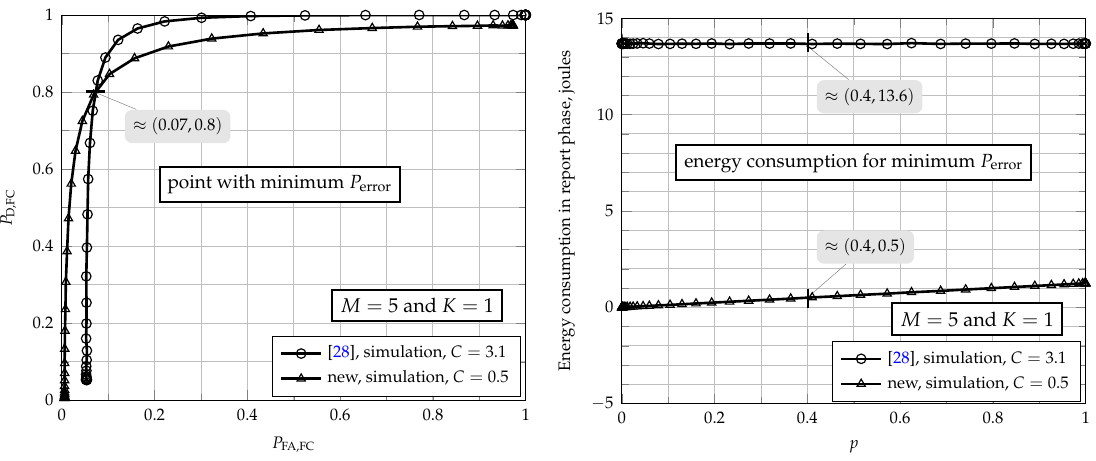
Figure 6. Performance (left) and energy consumption (right) for the new fusion scheme and for the one proposed in [28], for M = 5, γ SU = − 5 dB, γ FC = 5 dB and E = ξ =